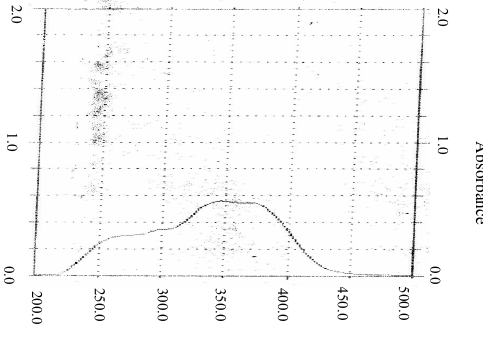
Figure 3. UV vis absorption spectrum of cefadroxil-NaOH reaction product (25 µ g/mL)